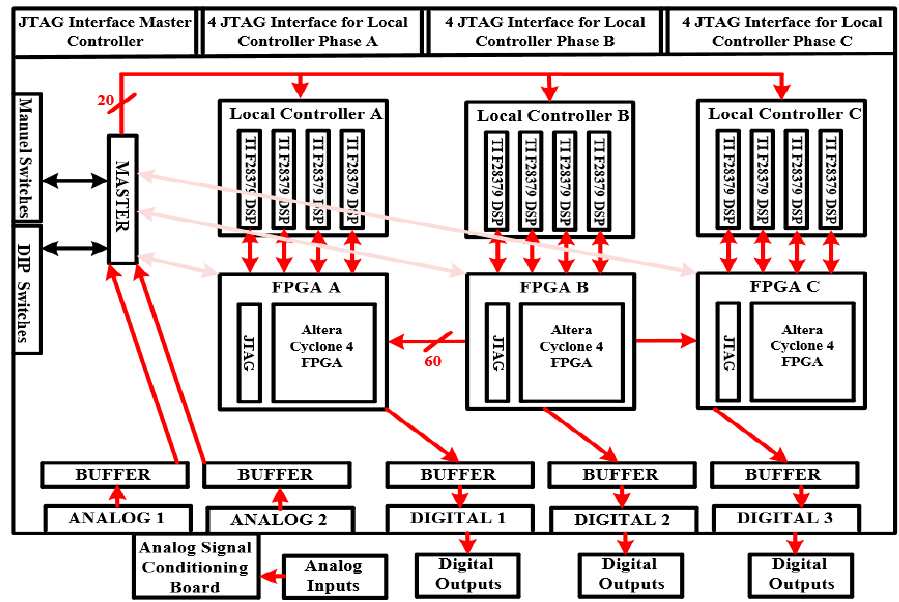
Figure 5. A block diagram of the controller.